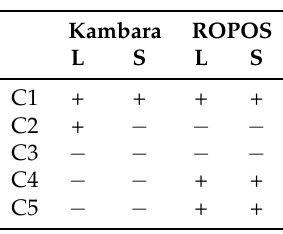
Table 3. Effectiveness of controllers based on